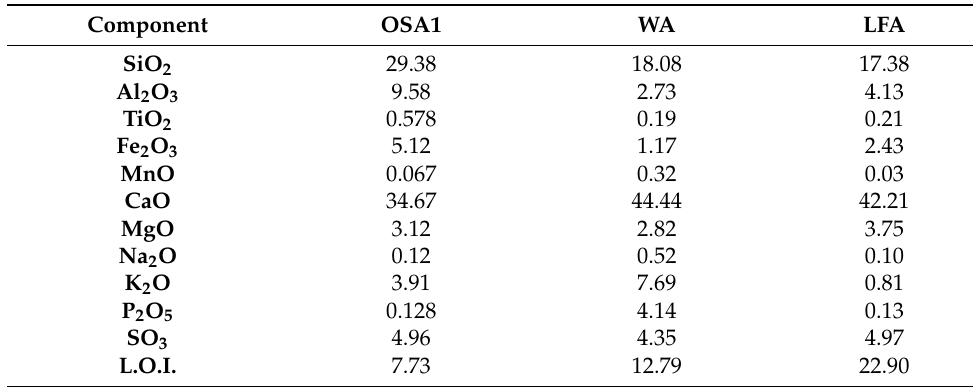
Table 1. Chemical composition of OSA, WA, and LFA.